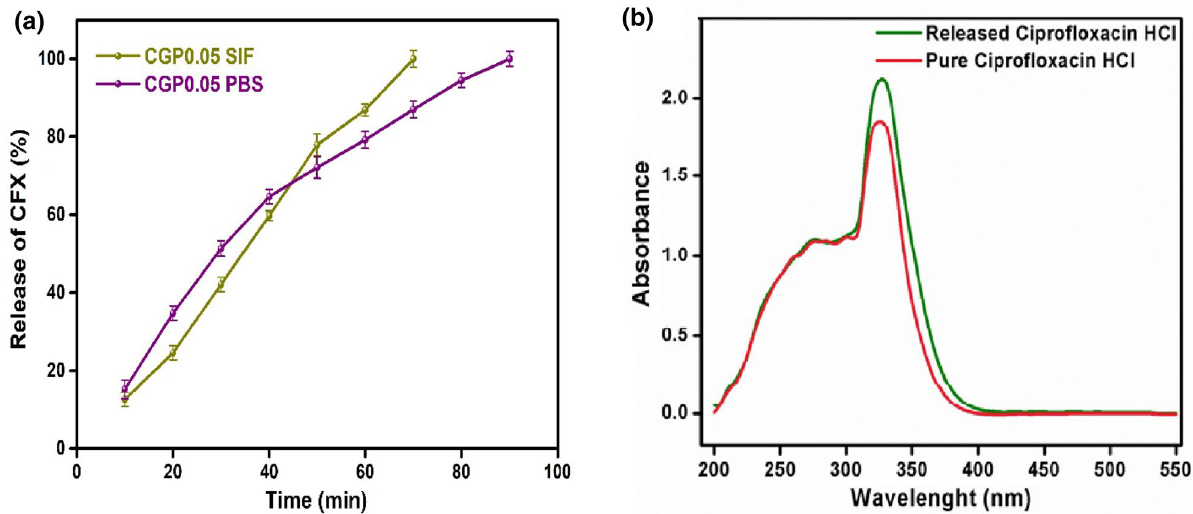
Figure 6. ( a ) Release analysis of CFH in SIF and PBS solutions with time. Data is presented as a mean ± SD (n = 3) ( b ) Chemical activity of pure ciprofloxacin HCl and after release from